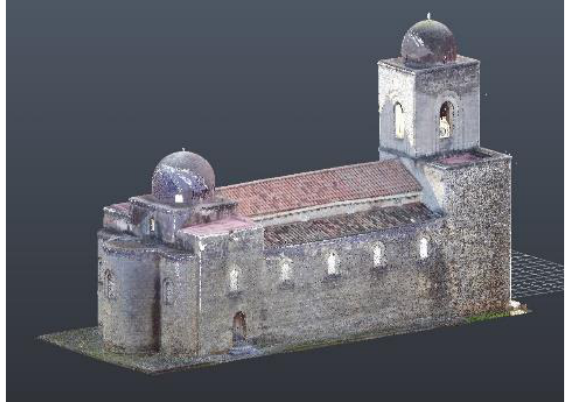
Figure 6. The final point